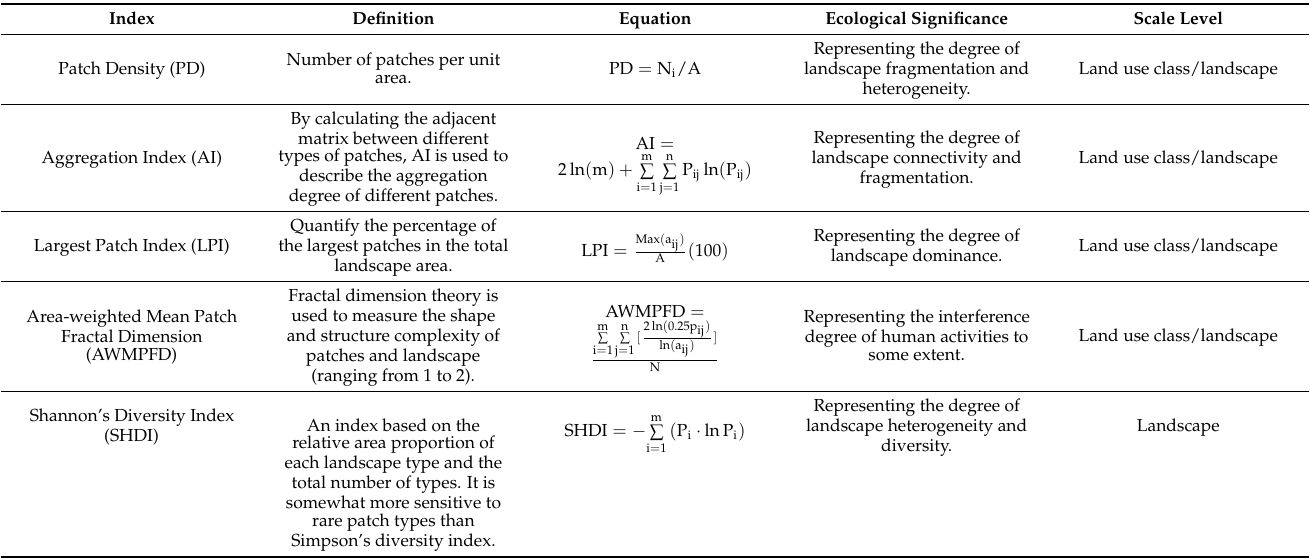
Table 1. Landscape metrics used in this study, their formula and ecological